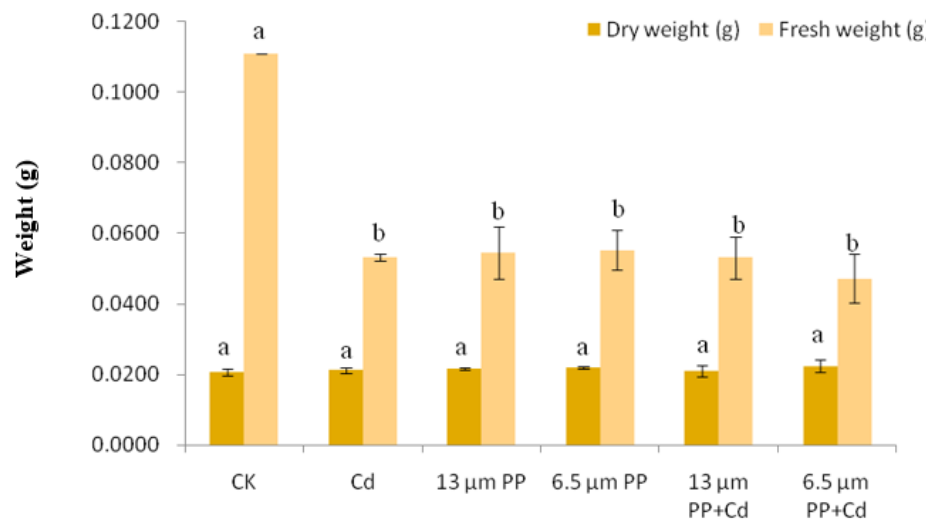
Figure 3. Effect of single and combined treatment of PP-MP and Cd on dry and fresh weight of rice seedlings. Results are shown in mean ± SD ( n = 9). Different letters a, b, c, d represent a significant difference between different treatments groups at the same MP particle size or at the same cadmium concentration (at p ≤ 0.05), whereas the same letters indicate insignificant differences between treatments. Where CK—Control check; Cd—Cadmium; PP—Polypropylene 3.3. Anti-oxidative enzyme activity.